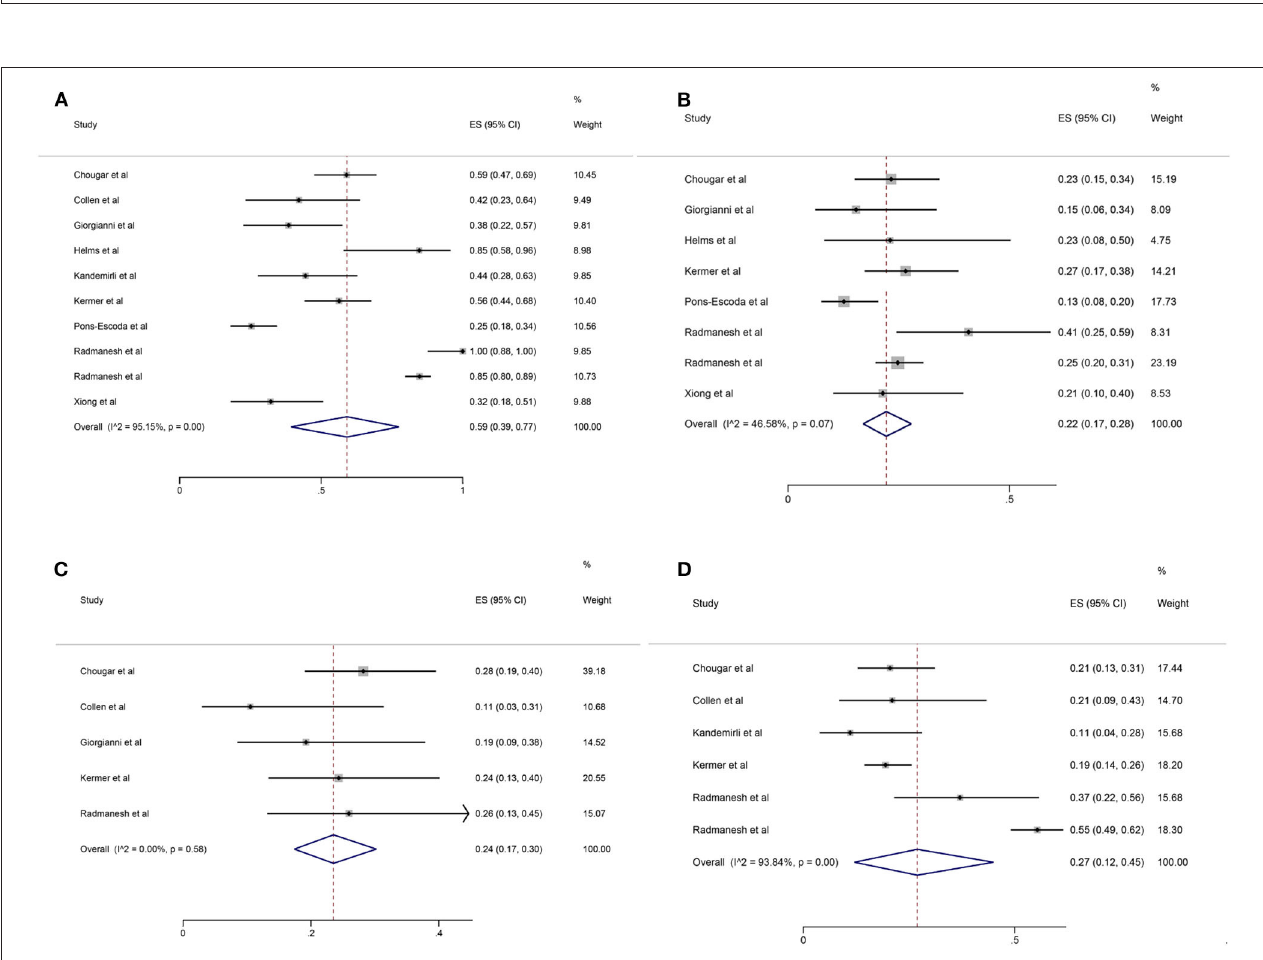
FIGURE 4 | Forest plot for the proportion of (A) abnormal neuroimaging finding; (B) acute/subacute ischemic infarction; (C) intracranial hemorrhage; (D) subcortical or deep white matter abnormalities in patients who exhibited neurological manifestation and underwent brain CT or MRI.